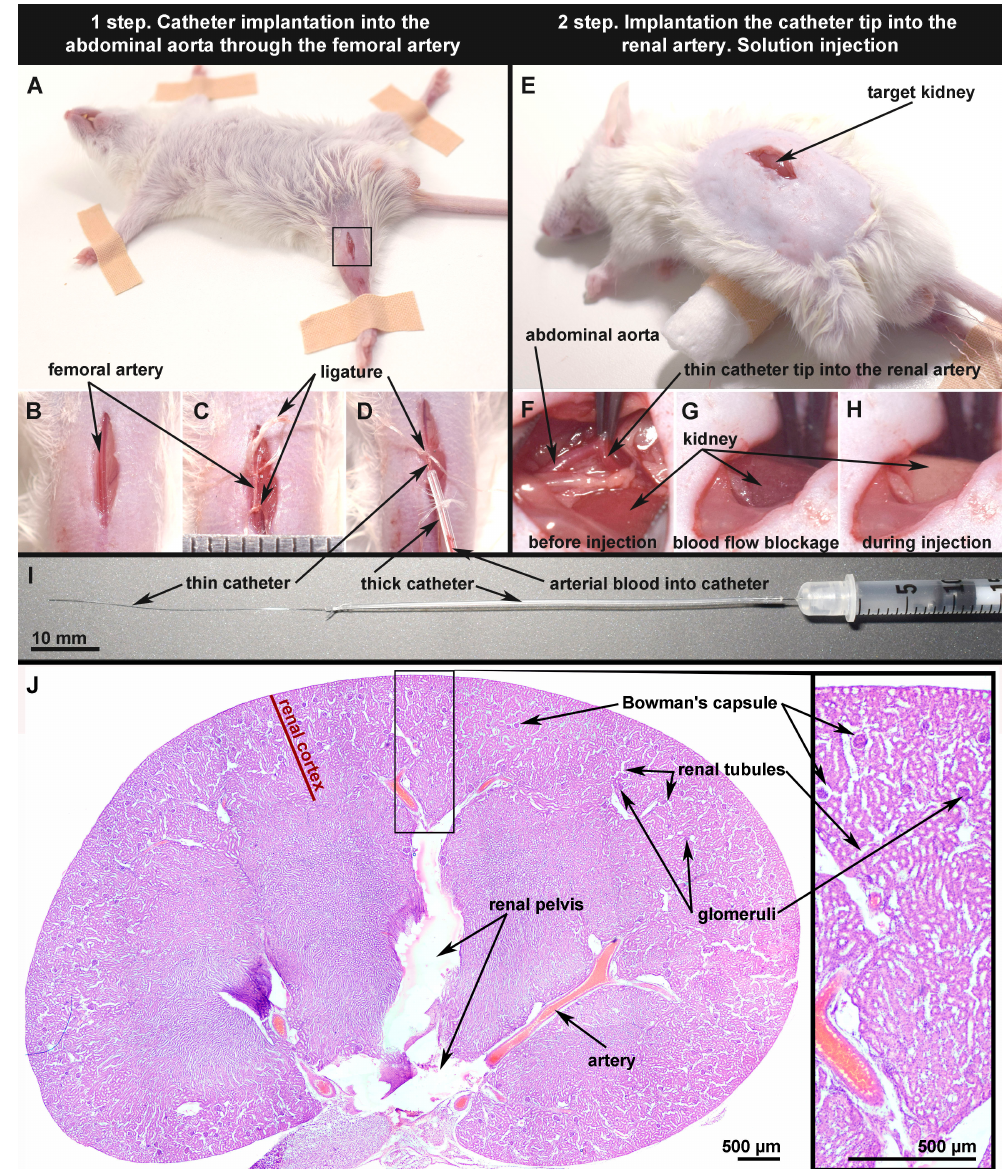
Figure 1. Main stages of the minimally invasive mouse renal artery catheterization technique ( A – H ) using polyurethane tubing ( I ); skin incision on the right thigh for access to the femoral artery marked with a black square ( A ). Renal artery before ( B ) and after ligation ( C ). The thin part of the catheter (4.5 cm, inner diameter 0.25 mm) is completely implanted in the renal artery. The arterial blood in the catheter indicates that implantation was performed correctly ( D ). Skin incision in parallel with the spine above the kidney for access to the abdominal aorta and renal artery ( E ). Catheter tip pushed into the renal artery through the abdominal aorta; the artery’s blood flow is preserved, and the targeted kidney has a normal color ( F ). Renal artery walls are tightly pressed to the catheter walls using tweezers to prevent the entering of injection solution into the aorta; the kidney has a dark color due to the blood flow blockage ( G ). The kidney color change from dark to light during injection indicates that the manipulation was performed correctly ( H ). The subgross histological image of the target kidney 5 days after the saline injection (sham operation) shows that the kidney tissue has a normal structure. The thickness of the histological samples is 5 µ m; dyes: hematoxylin and eosin (H & E) ( J